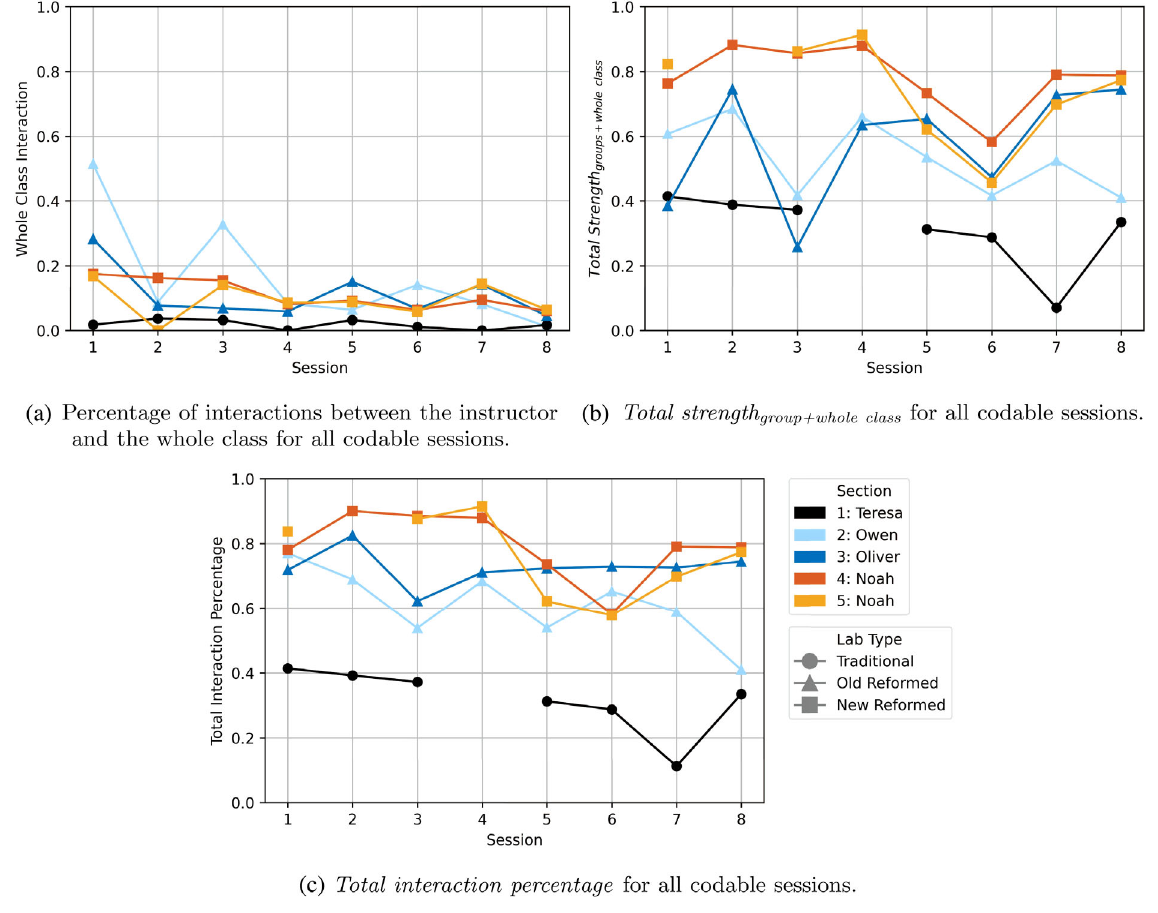
FIG. 3. Strength measures for (a) duration of instructor and whole class interactions only, (b) duration of instructor interactions with the whole class or individual groups, and (c) total duration of all instructor interactions and interactions involving a group and the whole class, all normalized by the duration of the lab session. Missing data points correspond to uncodable lab